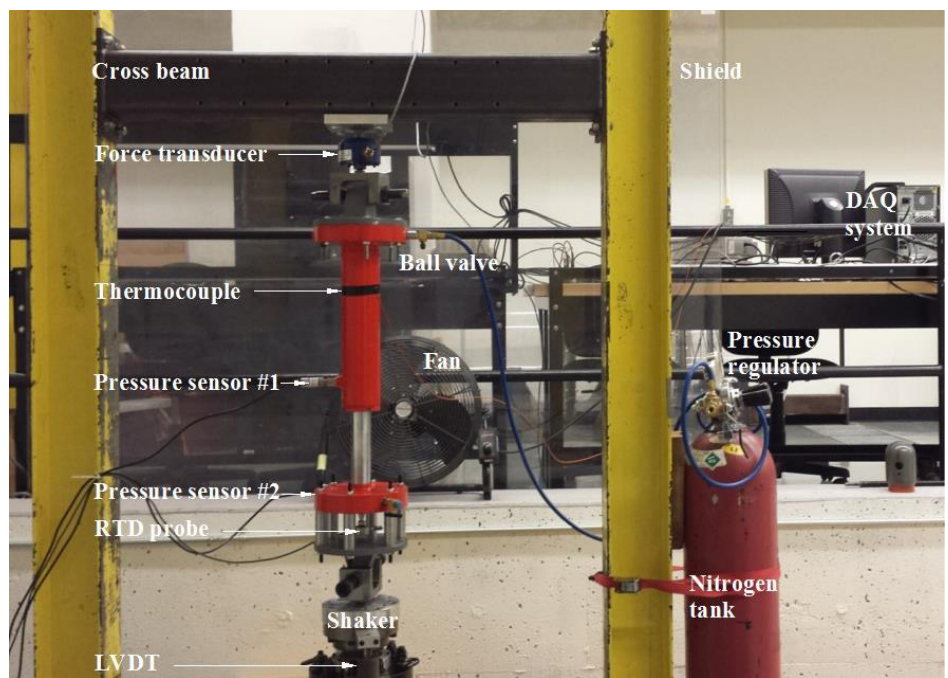
Figure 3. Laboratory experiment of an integrated hydro-pneumatic suspension prototype including cross-beam, force transducer, thermocouple, pressure sensor #1, pressure sensor #2, RTD probe, LVDT, shaker, fan, ball valve, shield, DAQ system, pressure regulator, and nitrogen tank.